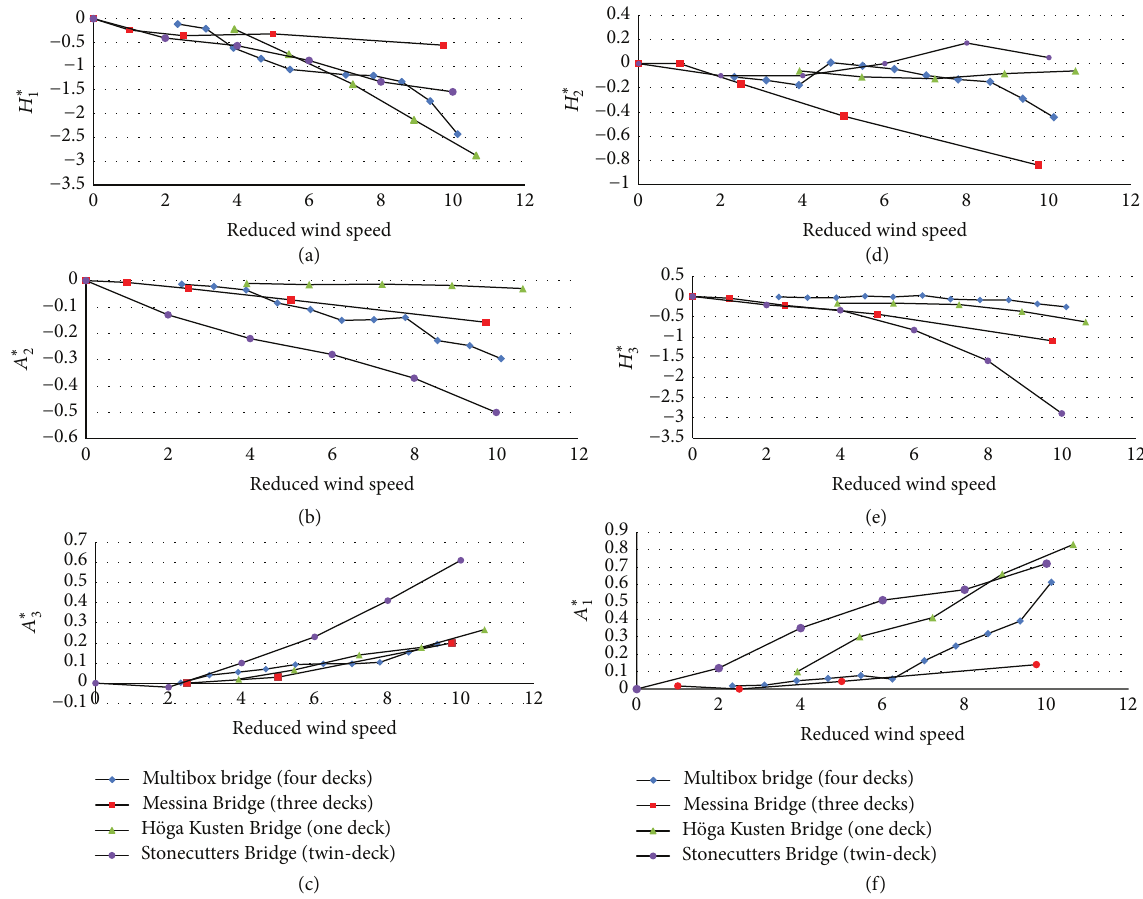
Figure 8: Direct and cross-flutter derivatives comparison for H¨oga Kusten Bridge, one box deck [28], Stonecutters Bridge, a twin-box deck [13], Messina Bridge three-box deck [29], and multibox bridge deck (current